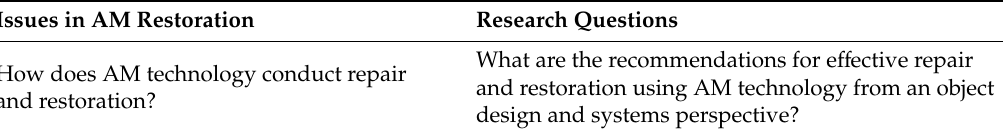
Table 3. Research